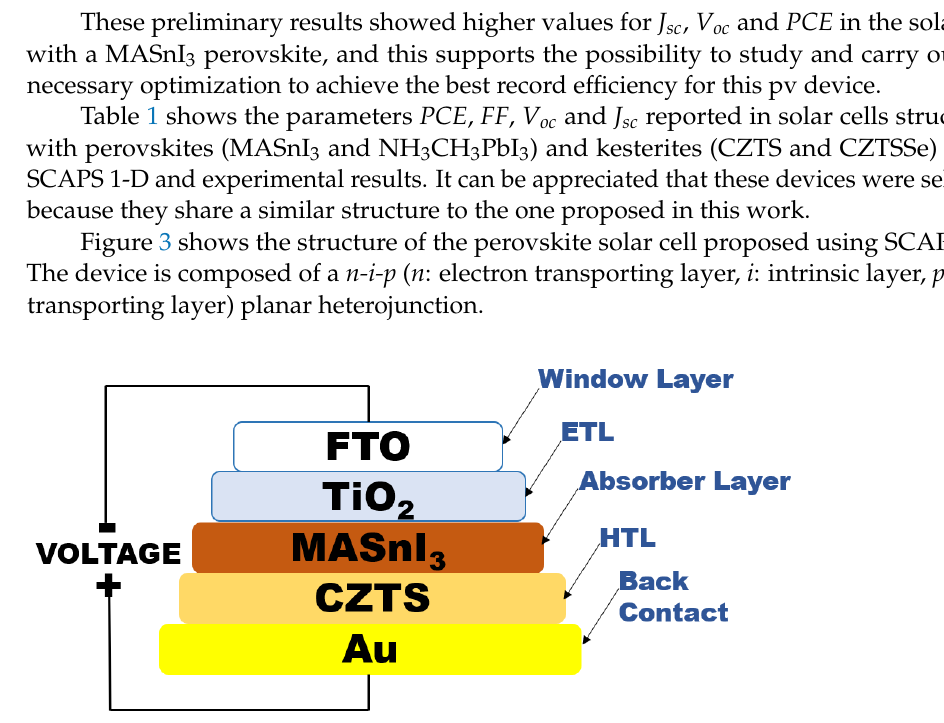
Table 2. Perovskite solar cell input optical and electric parameters [13].